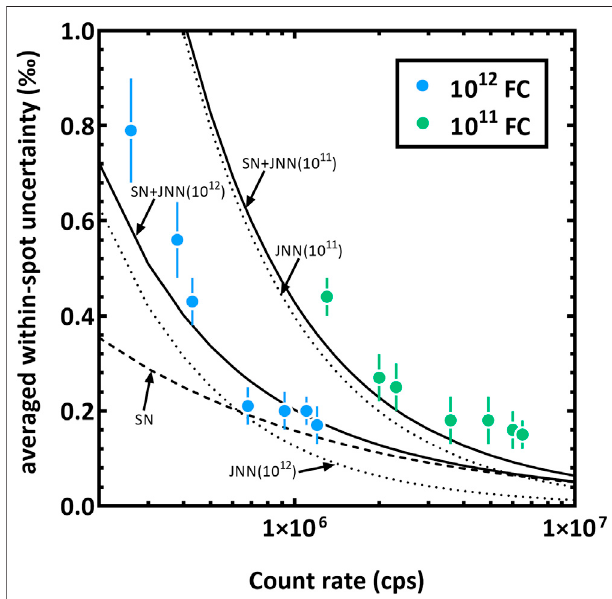
FIGURE 3 | Typical standard error (2SE) obtained for oxygen isotope measurements on FCs equipped with 10 11 Ω or 10 12 Ω preampli fi ers as a function of the count rate (in cps). Similar low standard errors are reached for count rates higher than ~5 × 10 5 cps for the 10 12 Ω preampli fi er and for countrateshigherthan~2.5 × 10 6 cpsforthe10 11 Ω ampli fi er.Shotnoise(SN, dashed lines),Johnson-Nyquistnoise(JNN,dottedlines)and SN+JNN(thick lines) theoretical variations are also shown (see text for details). Each data point is the average of fi ve analyses (the error bars are ±